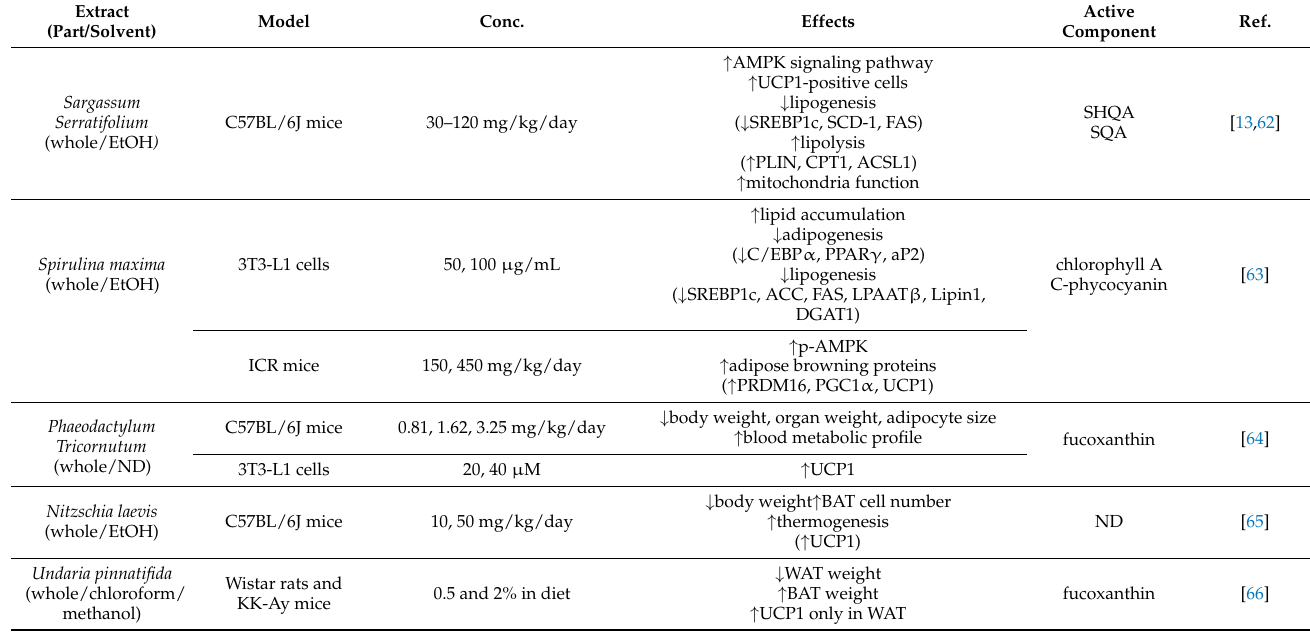
Table 3. Marine products to stimulate adipocyte